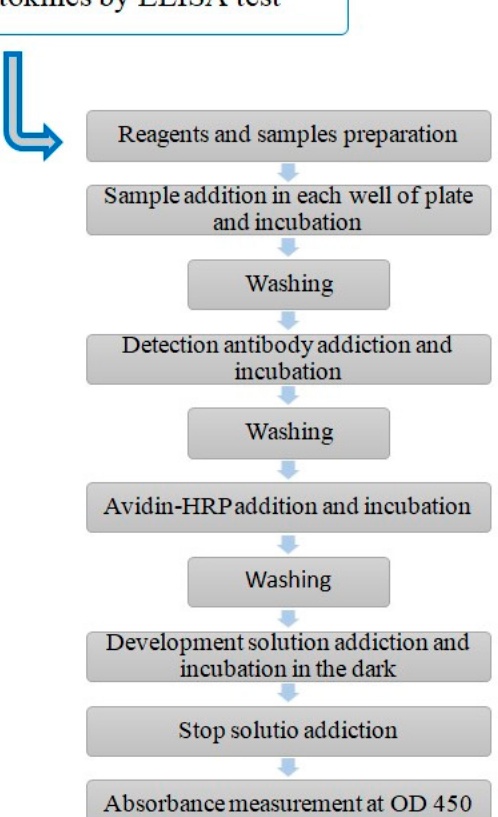
Figure 2. Flow chart of major steps followed in this study.